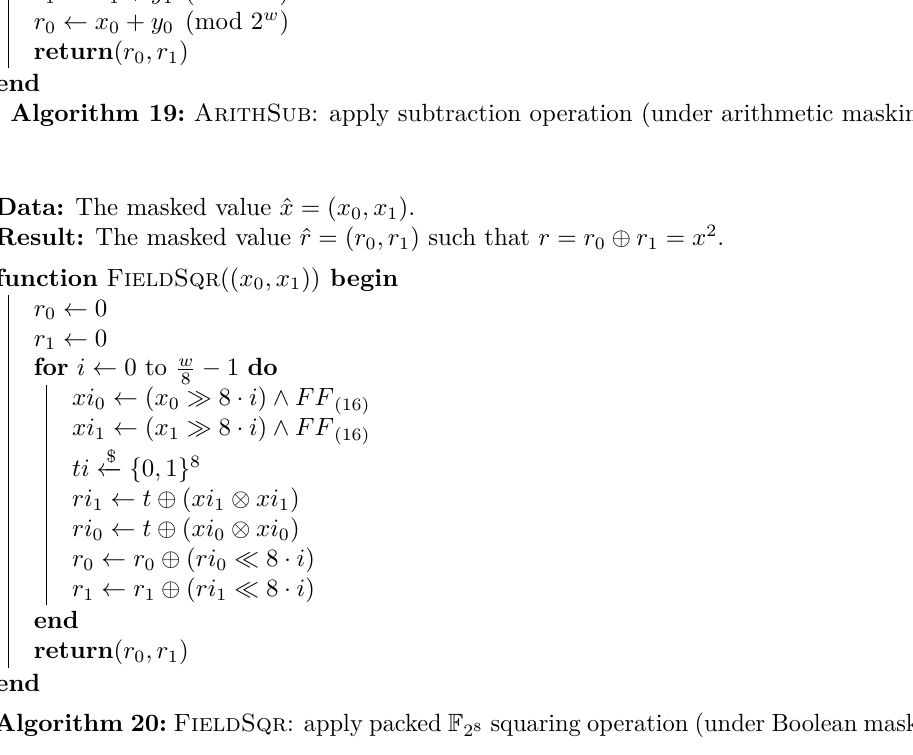
Algorithm 19: ArithSub : apply subtraction operation (under arithmetic masking).